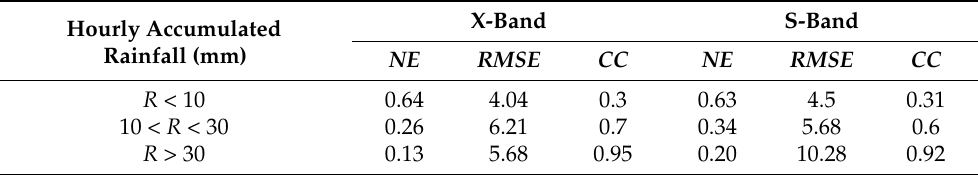
Table 2. NE , RMSE (mm), and CC between the hourly accumulated rainfall from R ( K DP ) and gauge measurements corresponding to Figure